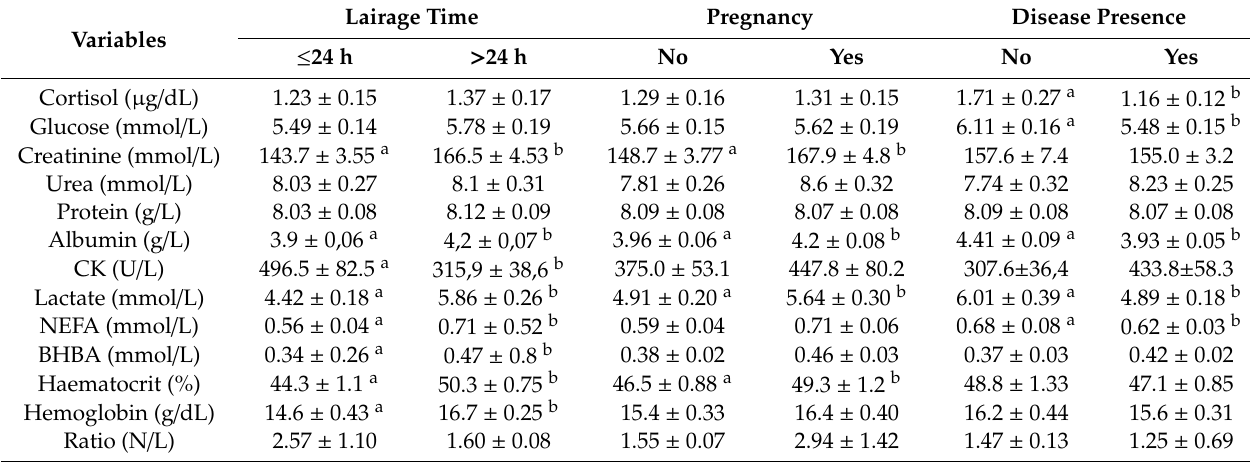
Table 5. Least square means of the physiological welfare indicators of cull cows at two di ff erent times of lairage, pregnancy, and disease presence. Lairage Time Pregnancy Disease Variables